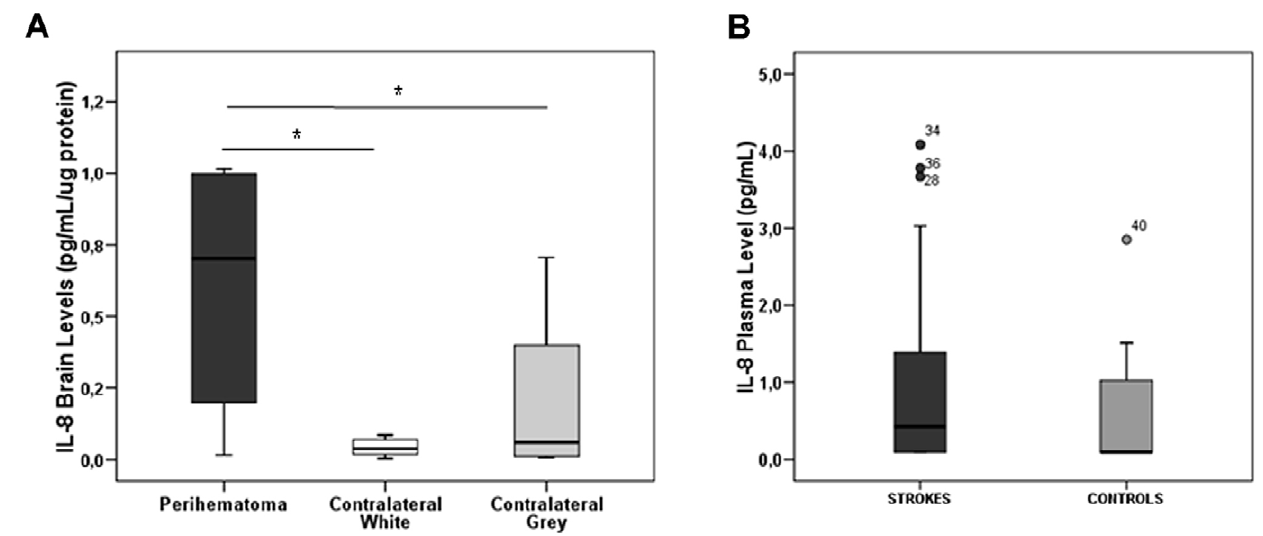
Figure 4. Validation studies at the protein level. Box-plots show how increased levels of IL-8 were found in perihematoma areas compared to both contralateral white and grey areas ( A ) and also in plasma of ICH stroke patients compared to controls ( B ). * p , 0.05.